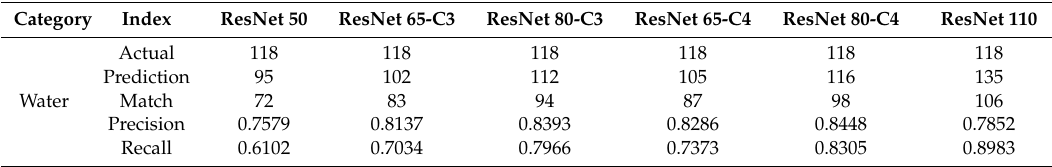
Table 3. Performance comparison of di ff erent depth networks.